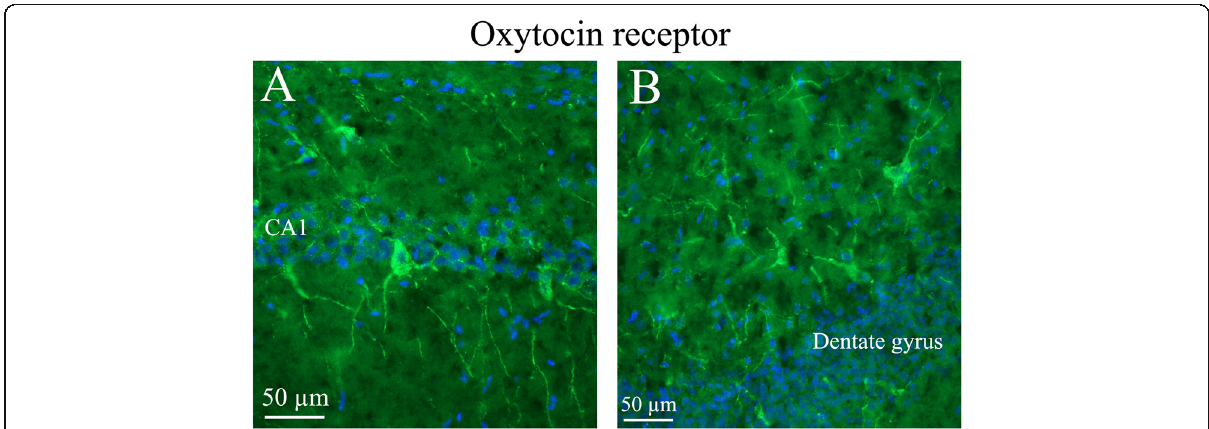
Fig. 12 Oxytocin receptor immunohistochemistry of the hippocampus. Oxytocin receptor expression was found in the CA1 and CA2 regions of the hippocampus (CA1, CA2) and in the dentate gyrus. a . The left panel demonstrates positive pyramidal neurons in CA1. b . The right panel shows neurons of the dentate gyrus, with oxytocin receptor expression in both the cell soma and the